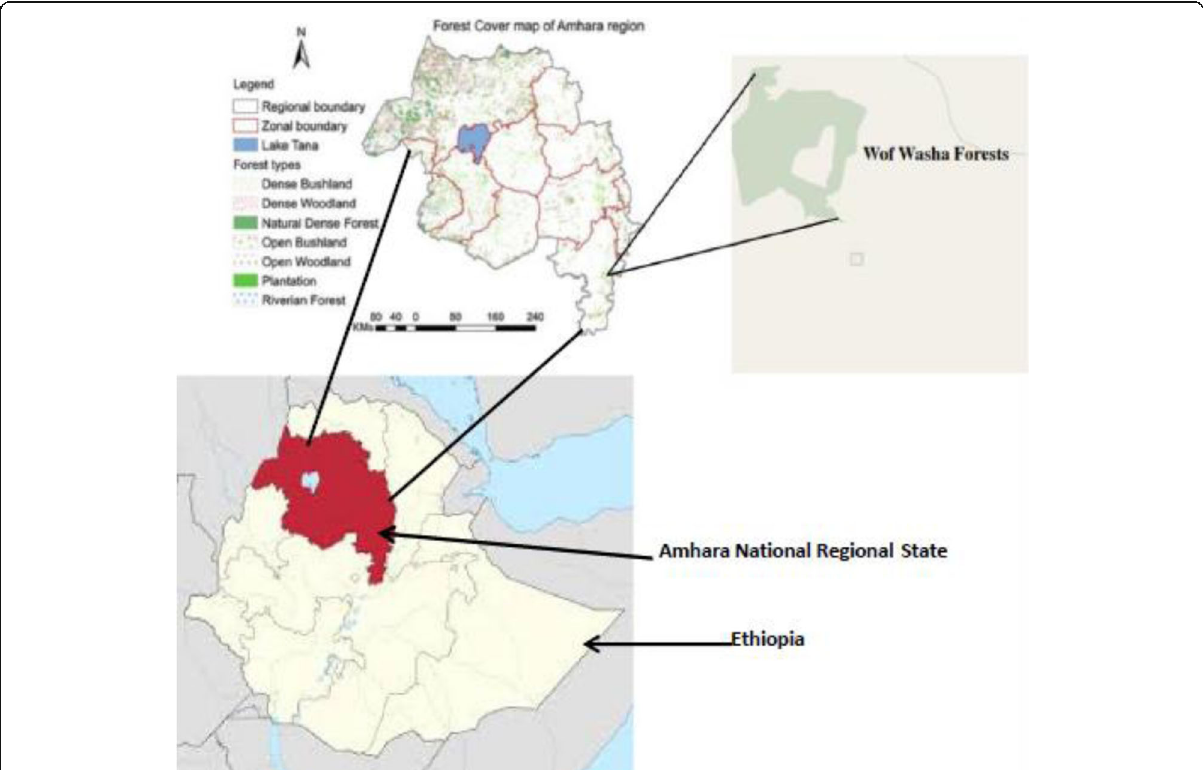
Fig. 1 Map showing the location of the Wof-Washa Forests in Amhara National Regional